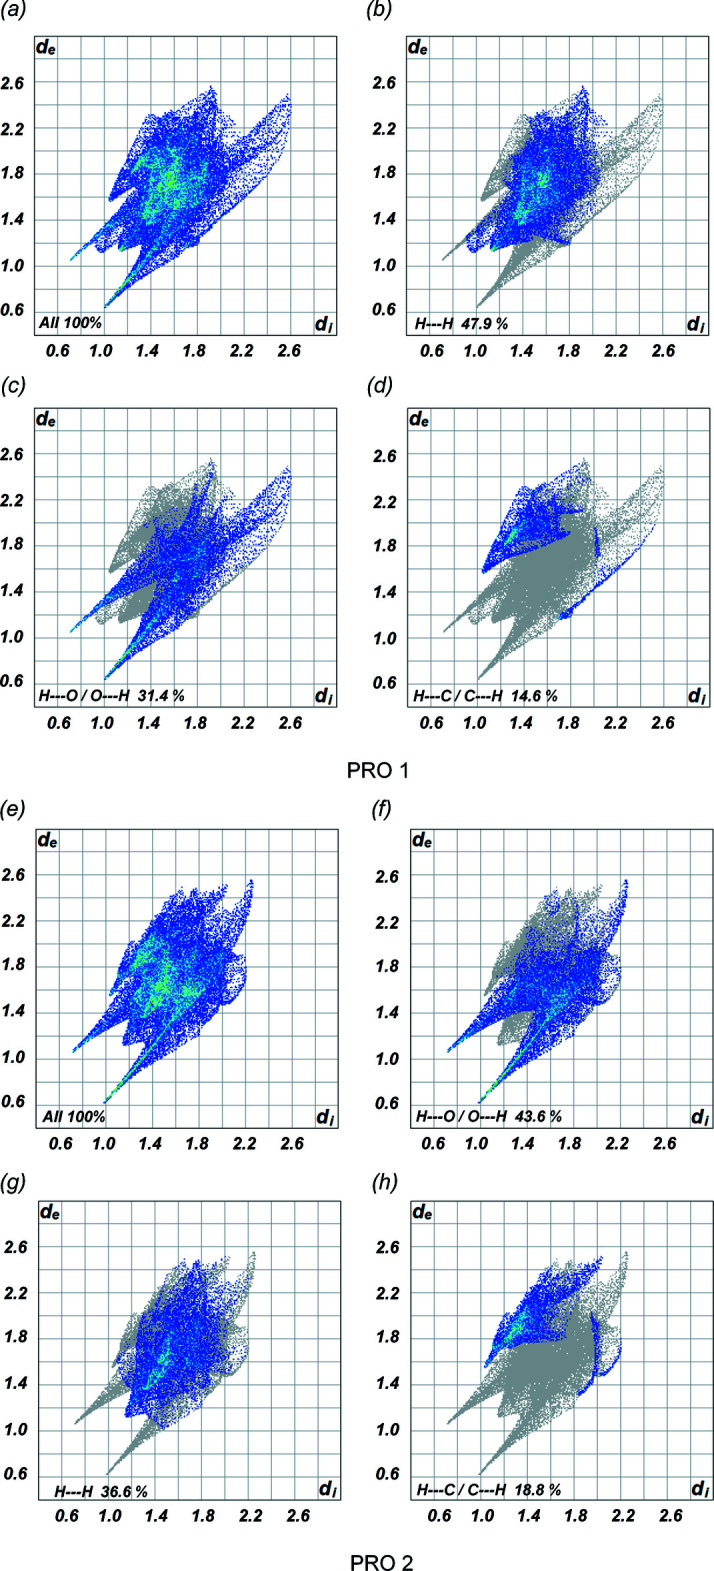
Fingerprint plots for the PRO mol­ecules in (I): (a)–(d) of PRO 1 and (e)–(h) of PRO 2.